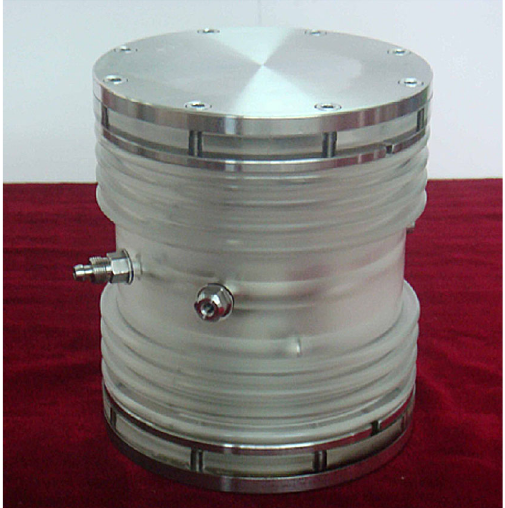
FIG. 2. The final MGS model used in the LTD system. The model has six gaps with total length of 30 mm. The maximum working voltage is about 200 kV and the average jitter is about 2.5